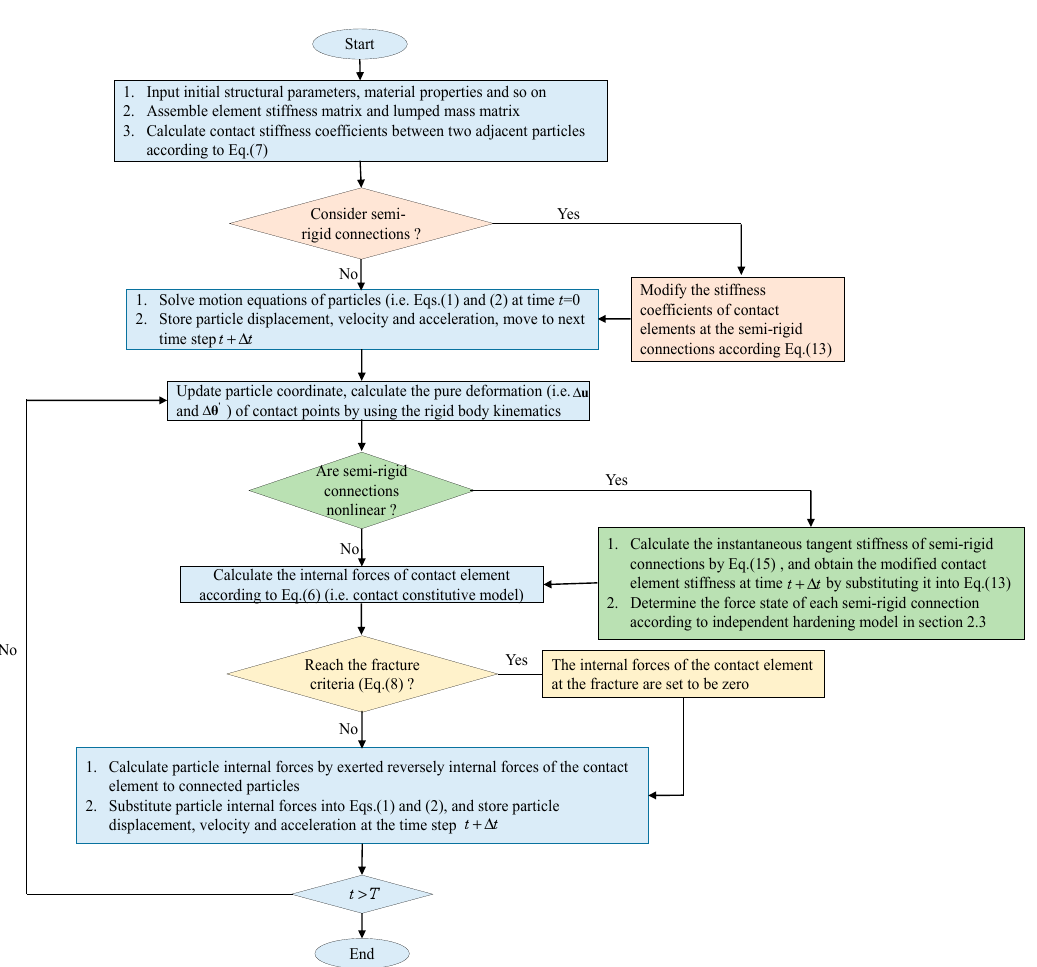
Figure 5. MDEM flowchart for static and dynamic analysis of steel frames with semi-rigid connections.